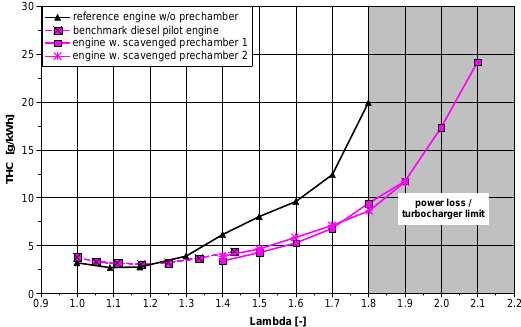
Fig. 21. Raw THC emissions for the operating point 2 (2000 rpm/220 Nm)